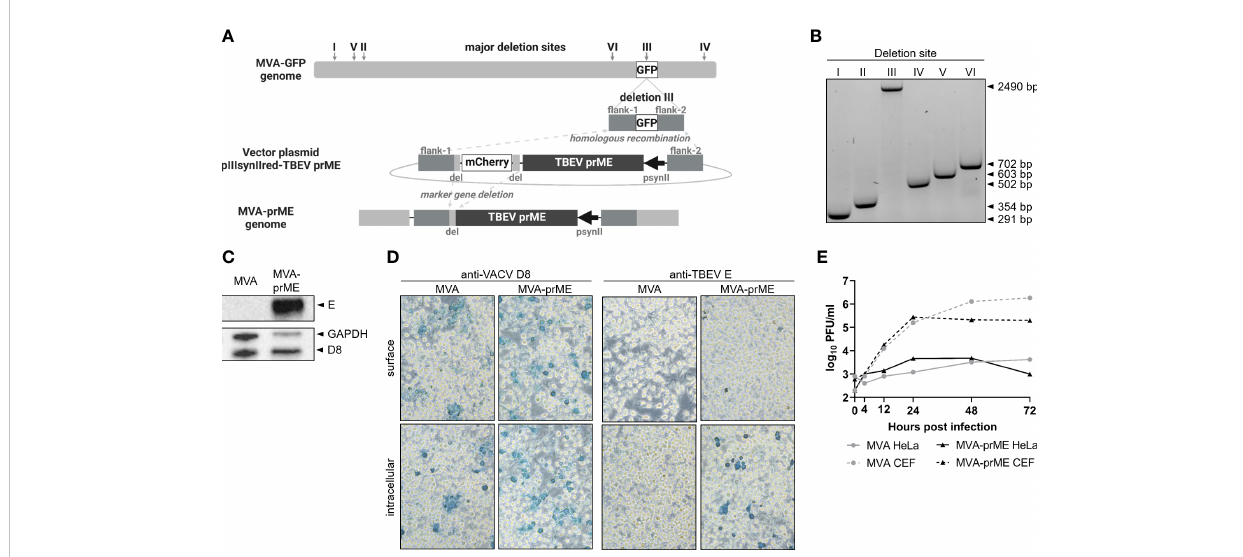
FIGURE 1 Generation of MVA-prME and in vitro characterization. (A) Homologous recombination within deletion site III of MVA-GFP and pIIIsynIIred-TBEV prME as well as intragenomic homologous recombination (marker gene deletion) generated recombinant MVA expressing prME of TBEV (MVA- prME). Created with BioRender.com. (B) Separation of DNA on 1% agarose TBE gel ampli fi ed by PCRs targeting the six major deletion sites of